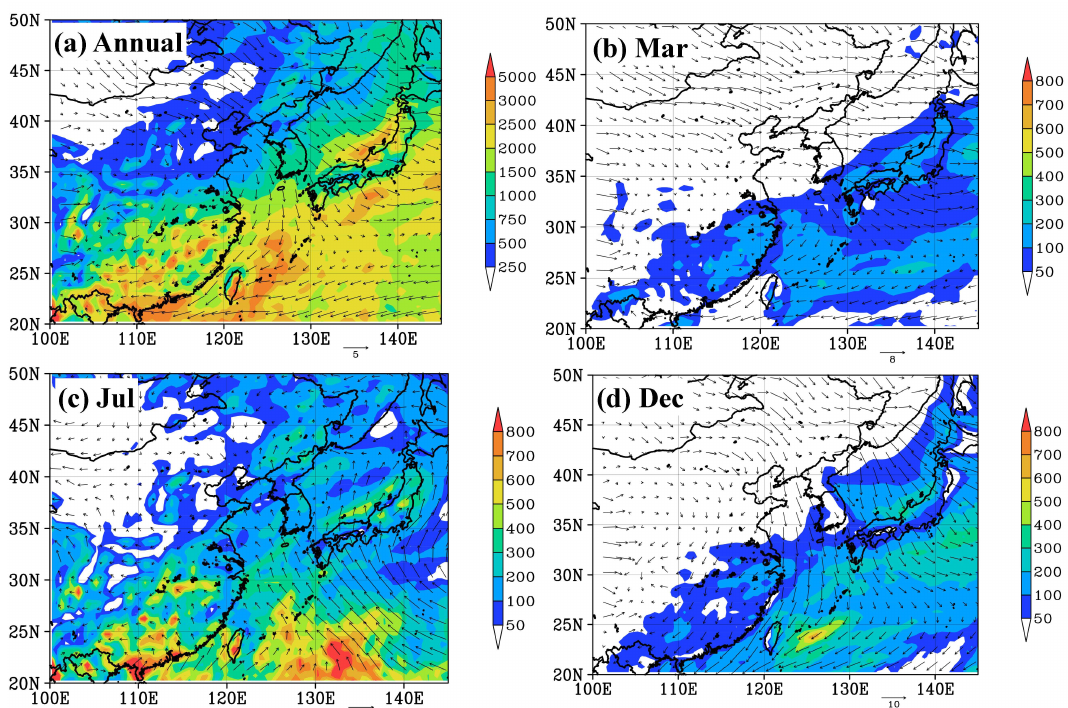
Fig. 2. Spatial distributions of (a) yearly and (b–d) monthly accumulated precipitation (mm) and mean surface wind field (ms − 1 ). The selected months, (b) March, (c) July, and (d) December, represent the spring, summer, and winter seasons,